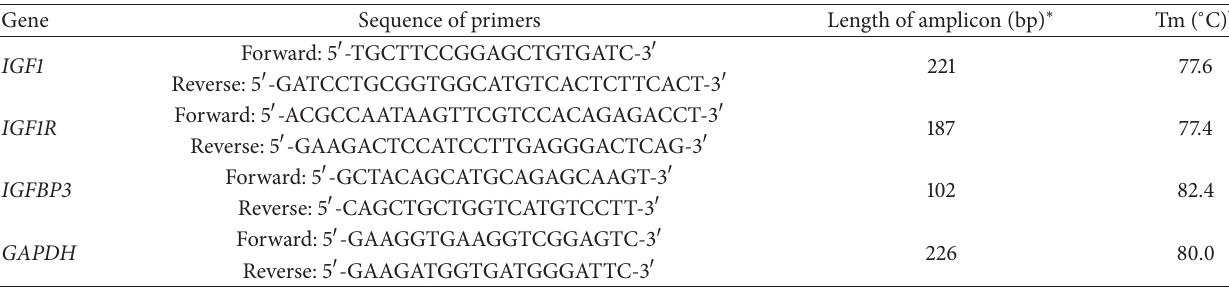
Table 2: Characteristics of primers used for real-time